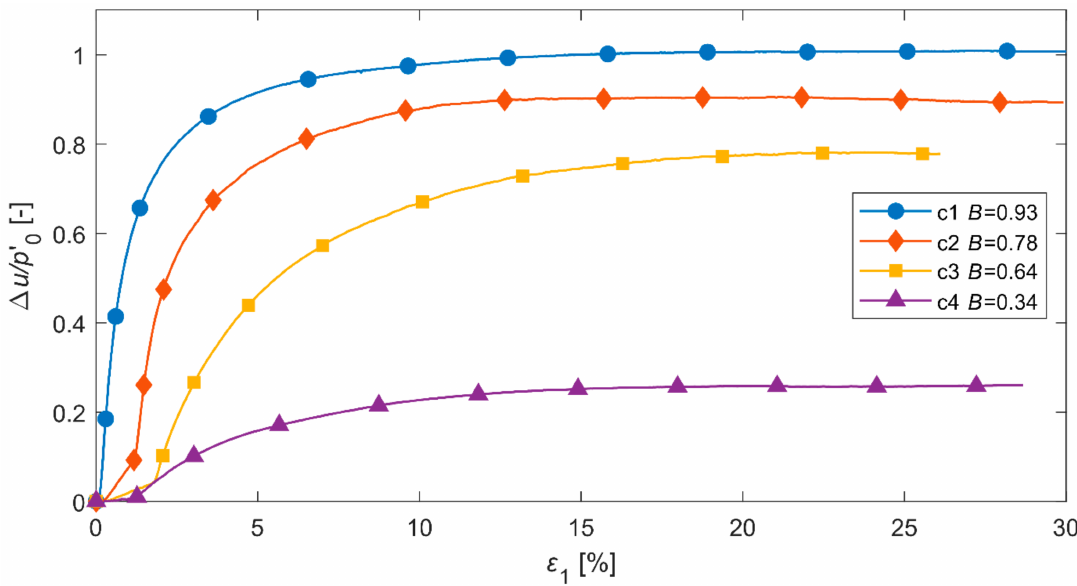
Figure 10. Response of Skarpa sand at different levels of saturation: normalized excess pore pressure vs. vertical